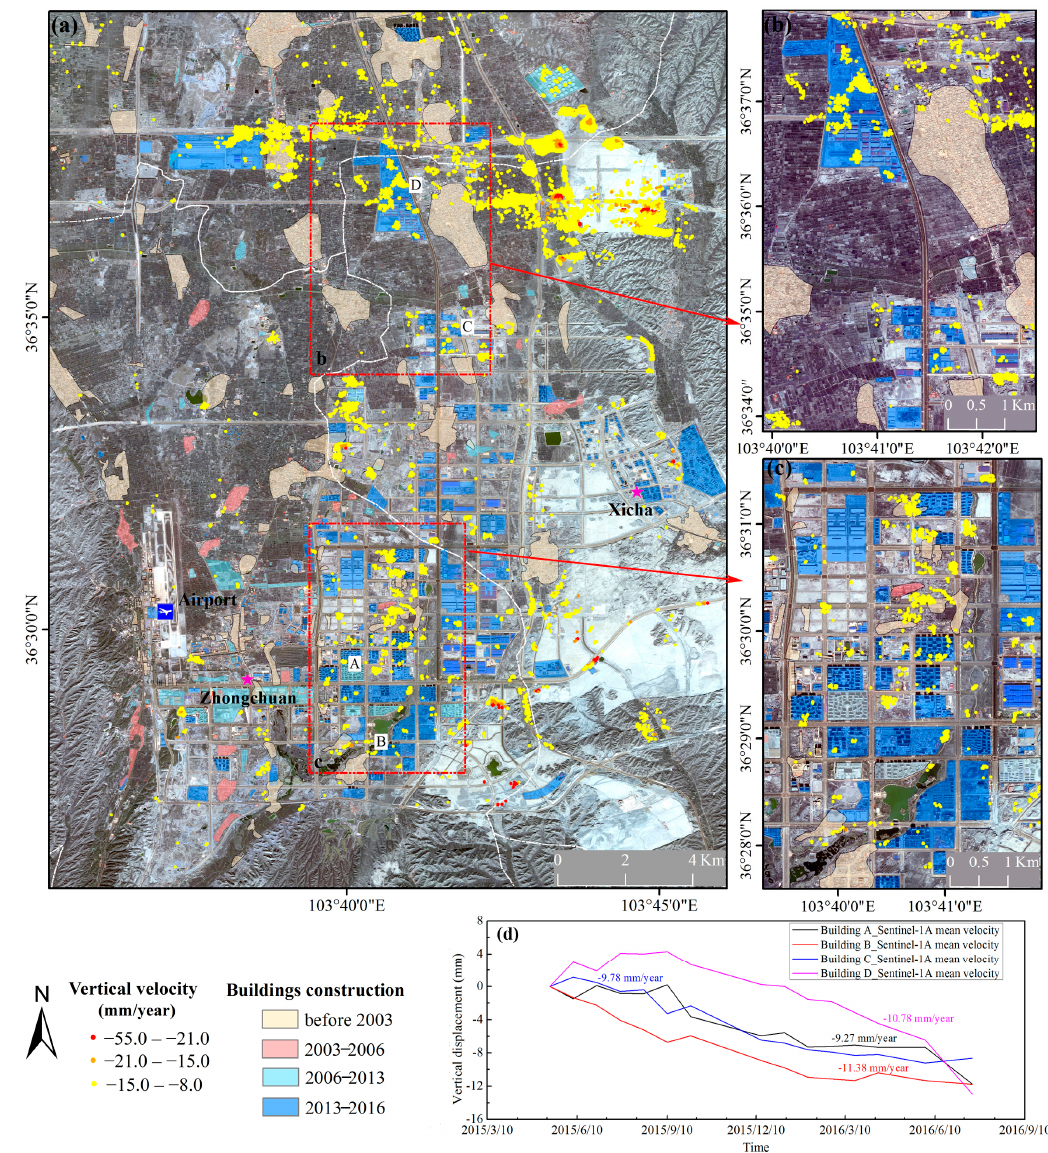
Figure 9. Localized subsidence in the main urban zone in relation to building construction: ( a ) Average subsidence rate from 2015–2016 and buildings constructed at different periods. The CTs are overlain on a 2016 GF-1 satellite image. ( b , c ) Enlarged views for the central Zhongchuan Town and newly-constructed industrial region of Xicha Town, respectively. ( d ) Envisat and Sentinel-1A time series for buildings A, B, C and D.